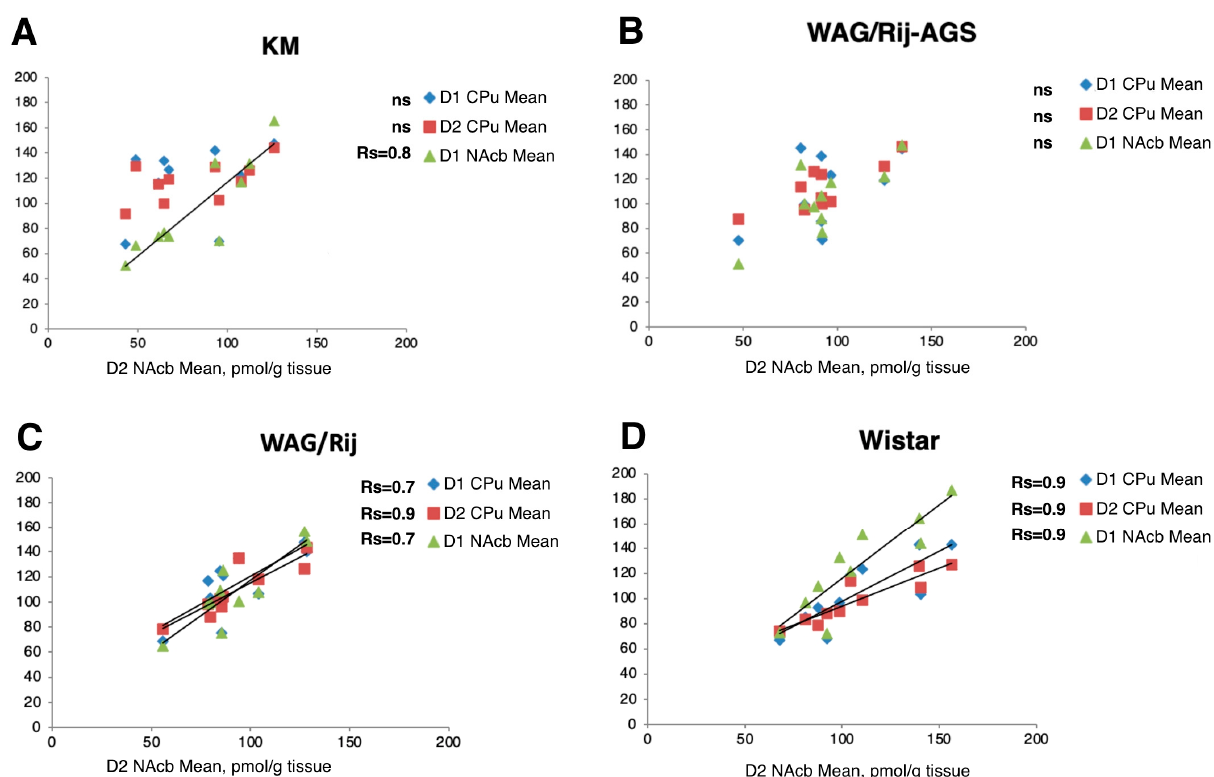
Figure 7. Brain regional binding densities to D1DR and D2DR correlate tightly in two non-AGS groups, but these local correlations are broken in the two AGS-prone cohorts. Axes are mean binding densities, in pmol/g. Each chart represents plots for the rat groups studied (Wistar, WAG/Rij, WAG/Rij-AGS, KM). Each data point represents mean regional D2DR NAcb density binding densities (pmol/g tissue) vs. D1DR or D2DR density in dorsal (blue diamonds for CPU, D1DR; red squares for CPU, D2DR) or ventral striatum parts (green triangles for NAcb, D1DR). In spearman rank order, Rs are given on the charts for significant local correlations ( p < 0.05), “ns” stands for non-significant ones.